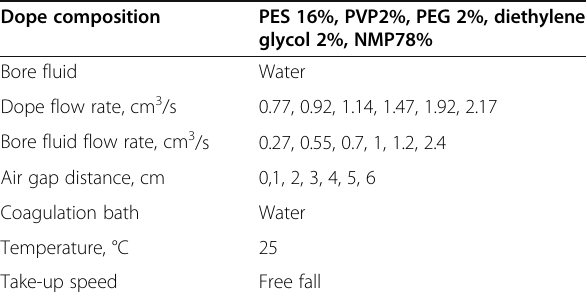
Table 3 Spinning conditions ranges